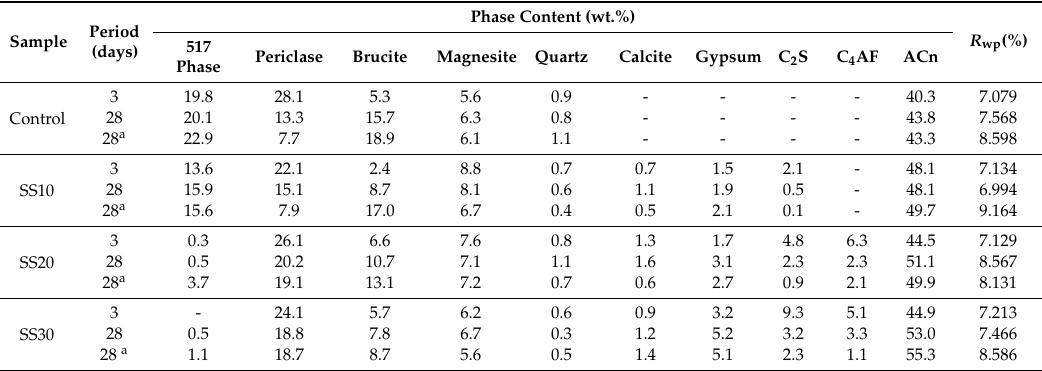
Figure 3. Compressive strengths of the control, SS10, SS20, SS30, SS40, and SS60 with CO 2 treatment at 3 days, 7 days, and 28 days. Table 4. Component concentrations in the control, SS10, SS20, and SS30 with CO 2 treatment curing at 3 days, 28 days, and after immersed in water for 28 days.